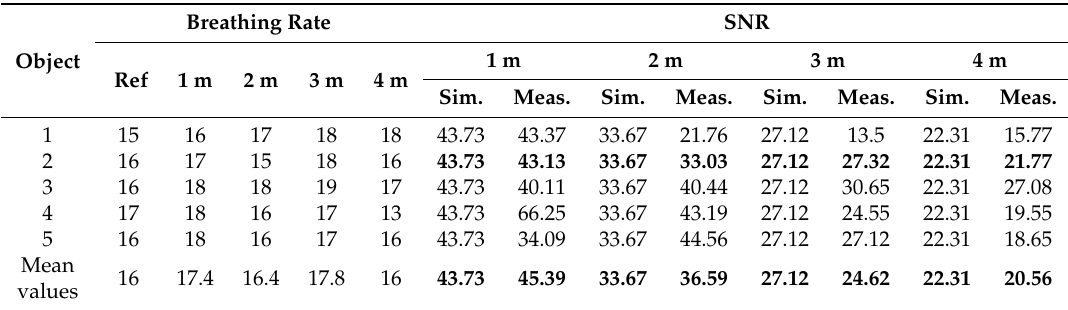
Figure 7. Measurement setup to detect the breathing rate. Table 2. Respiratory rates and signal-to-noise ratio (SNR) from five objects at different